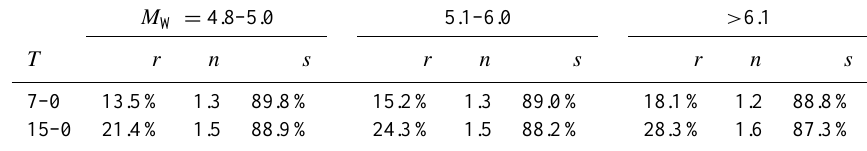
Table 2. The statistical results concerning seismic ionospheric influences on the ion density ( D = 0–500km, d = 0–20km). M W = 4.8–5.0